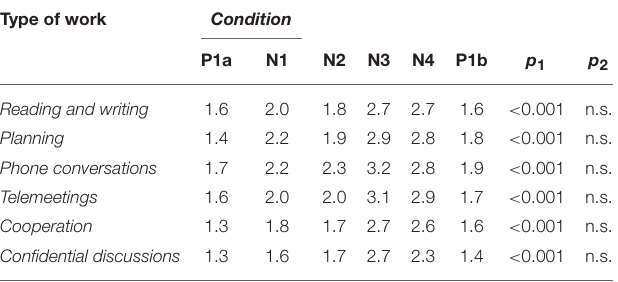
TABLE 6 | The perceived effect of sounds on performance in different tasks. Type of work